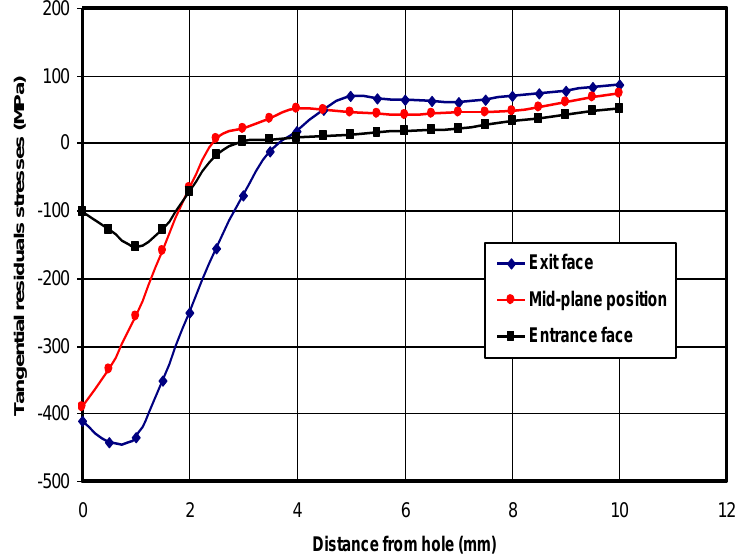
Figure 4: Tangential residual stress at different through-thickness positions for 6.32 mm in thick of plate.